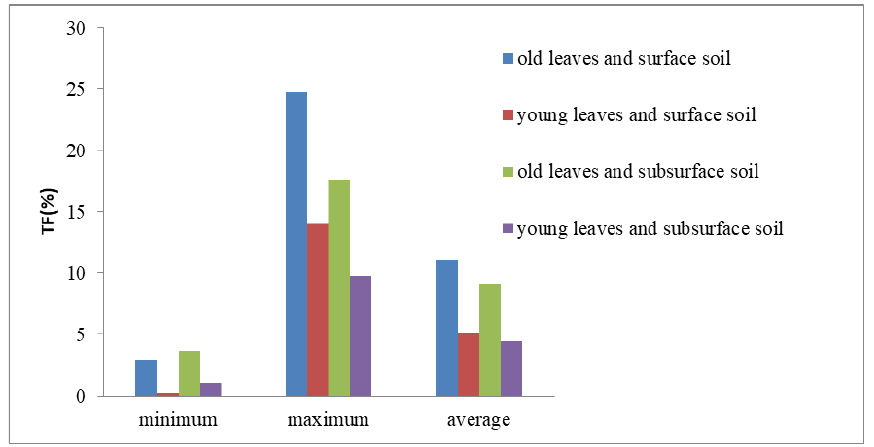
Figure 4. TF of Hg from soil to tea leaves.